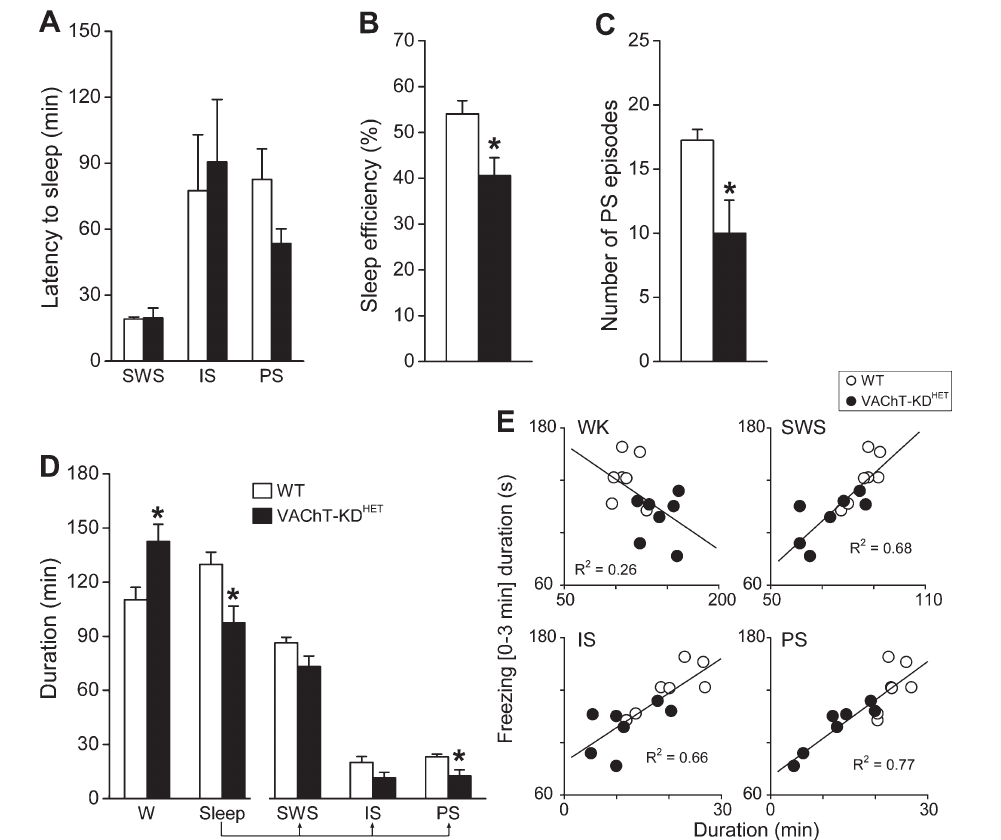
Figure 5. Impact of contextual fear conditioning test on sleep profile during the 4-h period after training. A , The latency to enter each of the sleep states was unaltered in VAChT-KD HET mice after training. B , Sleep efficiency during the 4-h period after the training session, and C , the number of PS episodes after the training session were significantly reduced in VAChT-KD HET animals. D , Averaged duration of each state during the 4-h period that followed the training session. Note that sleep reduction was mainly characterized by reduction of PS (arrows). E , Correlation between freezing duration in the first 3 min of the test and the duration of wake (WK), slow-wave sleep (SWS), intermediate sleep (IS), and paradoxical sleep (PS). Positive correlations (simple linear regression analysis) were observed for all sleep states (P , 0.05) but not for waking (P . 0.05). WT: wild-type mice (n=7); VAChT-KD HET : vesicular acetylcholine transporter knockdown heterozygous mice (n=7); W: awake. *P , 0.05 (Student t